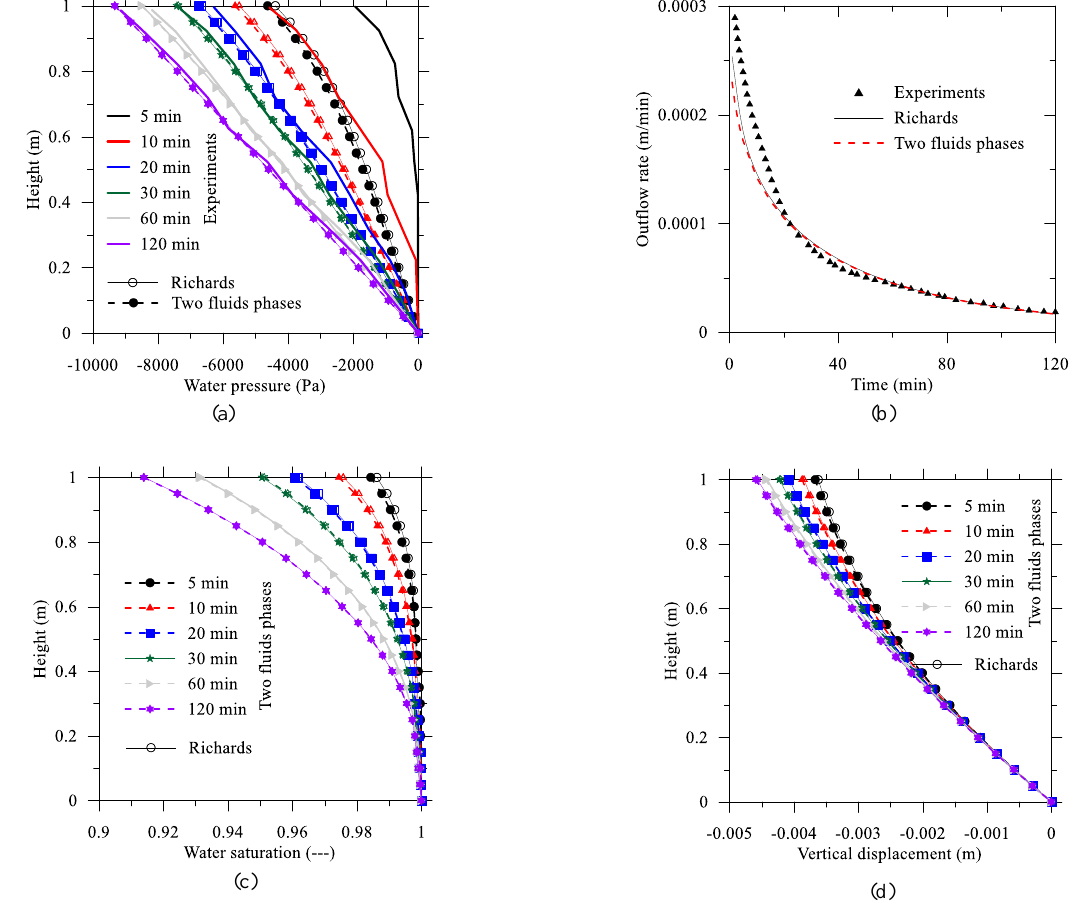
Figure 6. Finite element results and Liakopoulos experiments: ( a ) water pressure, ( b ) outflow rate, ( c ) water saturation, and ( d ) vertical displacement.